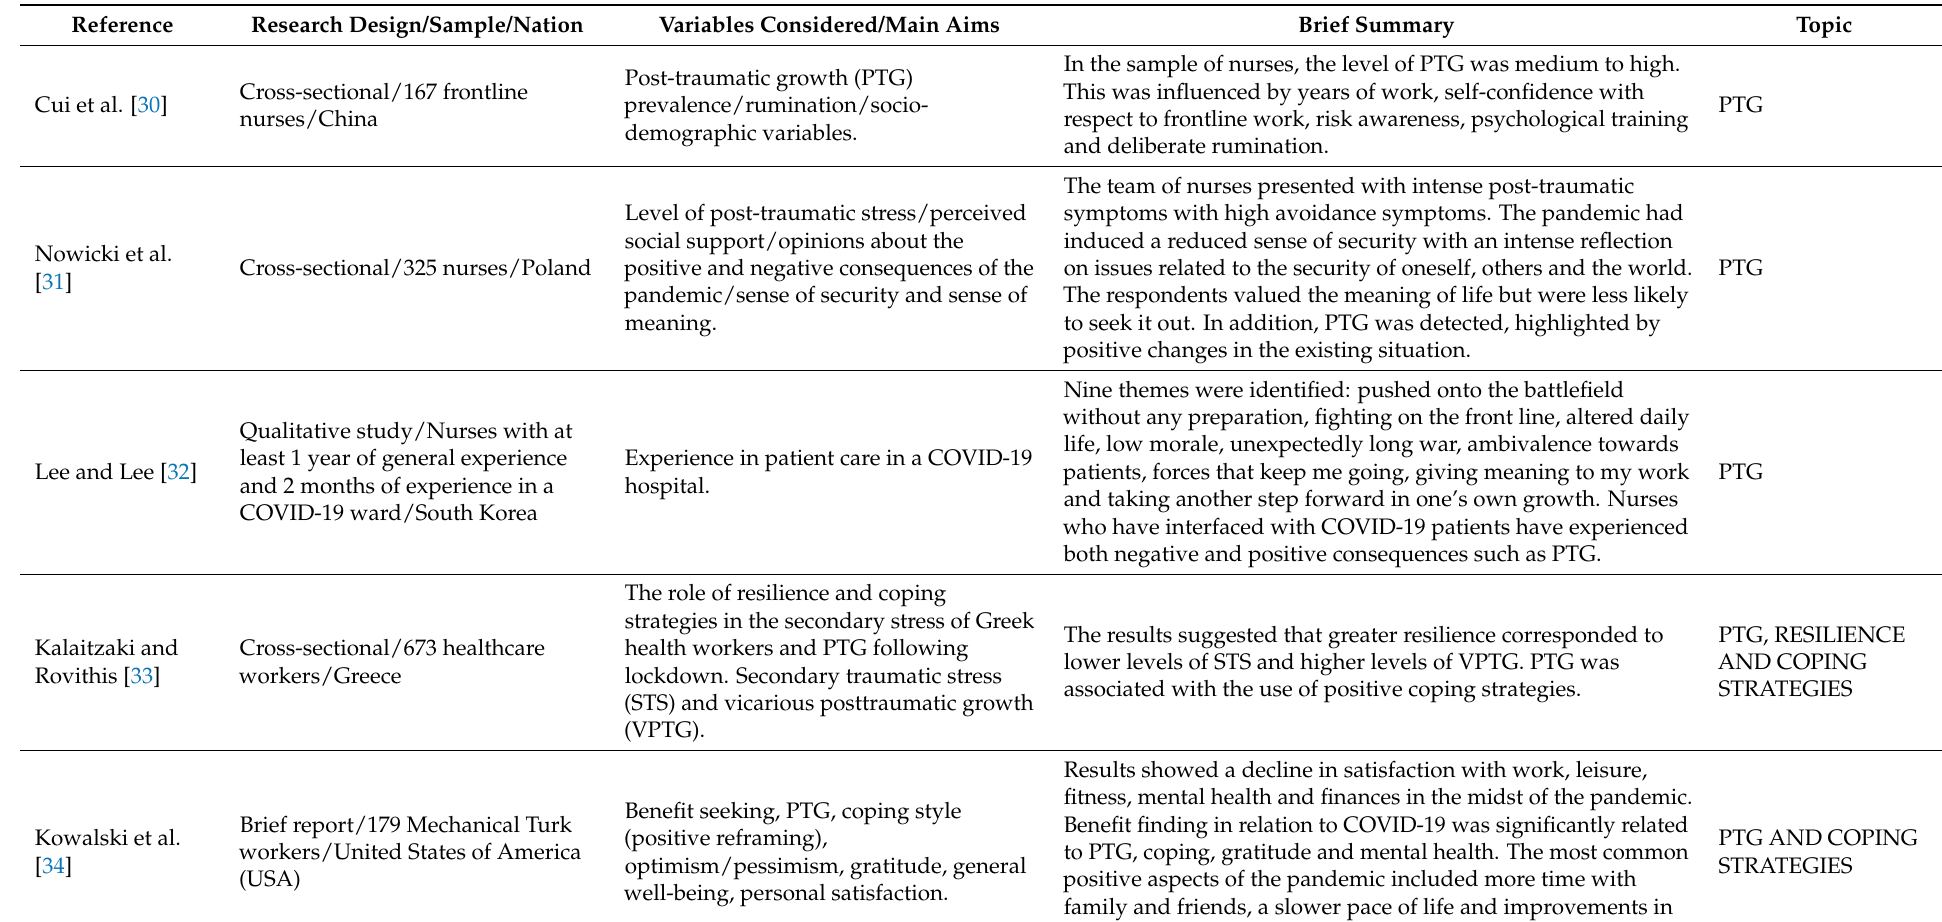
Table 1. Summary of articles included in the narrative